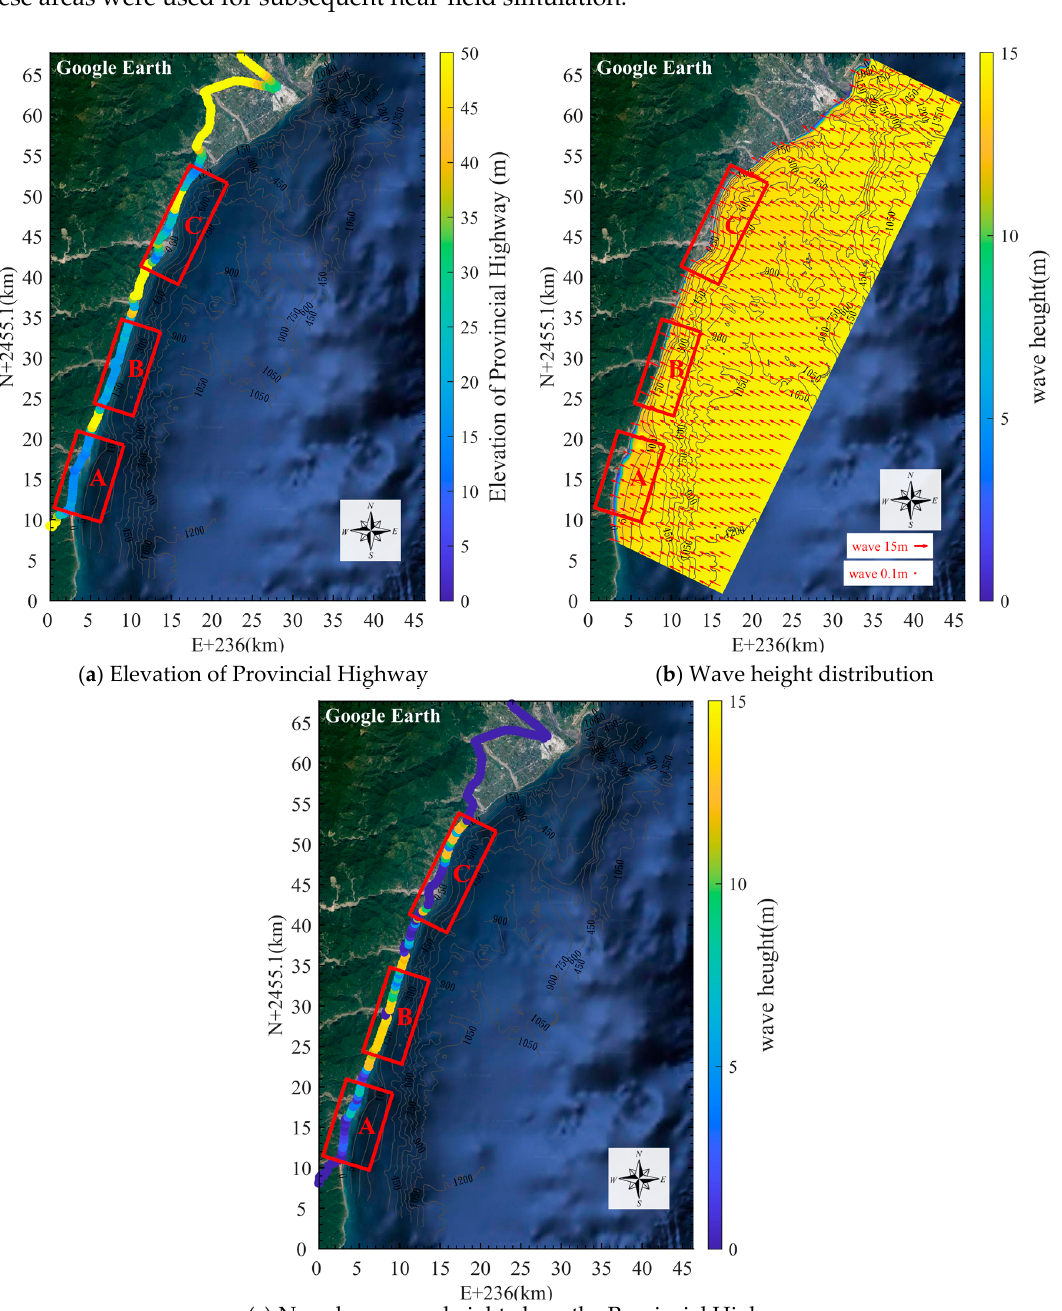
Figure 18. Provincial Highway elevation, distribution of wave height, and distribution of nearshore wave height.